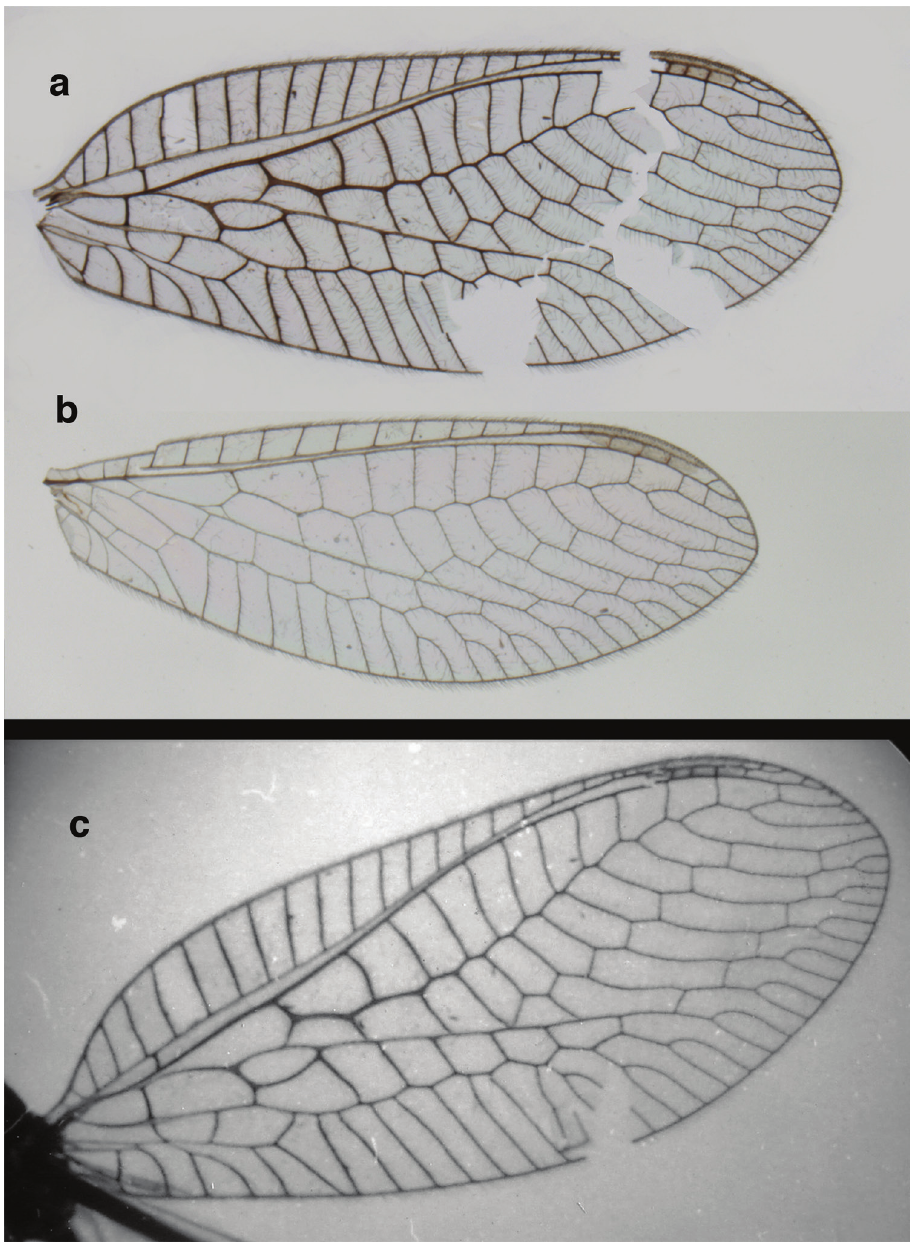
Figure 12. Ungla banksi Tauber, new replacement name: Wings, ( a ) forewing (damaged) ( b ) hindwing ( c ) photo of forewing taken by P. A. Adams (~1970) before severe damage (Bolivia, Rio Zongo, holotype, male,